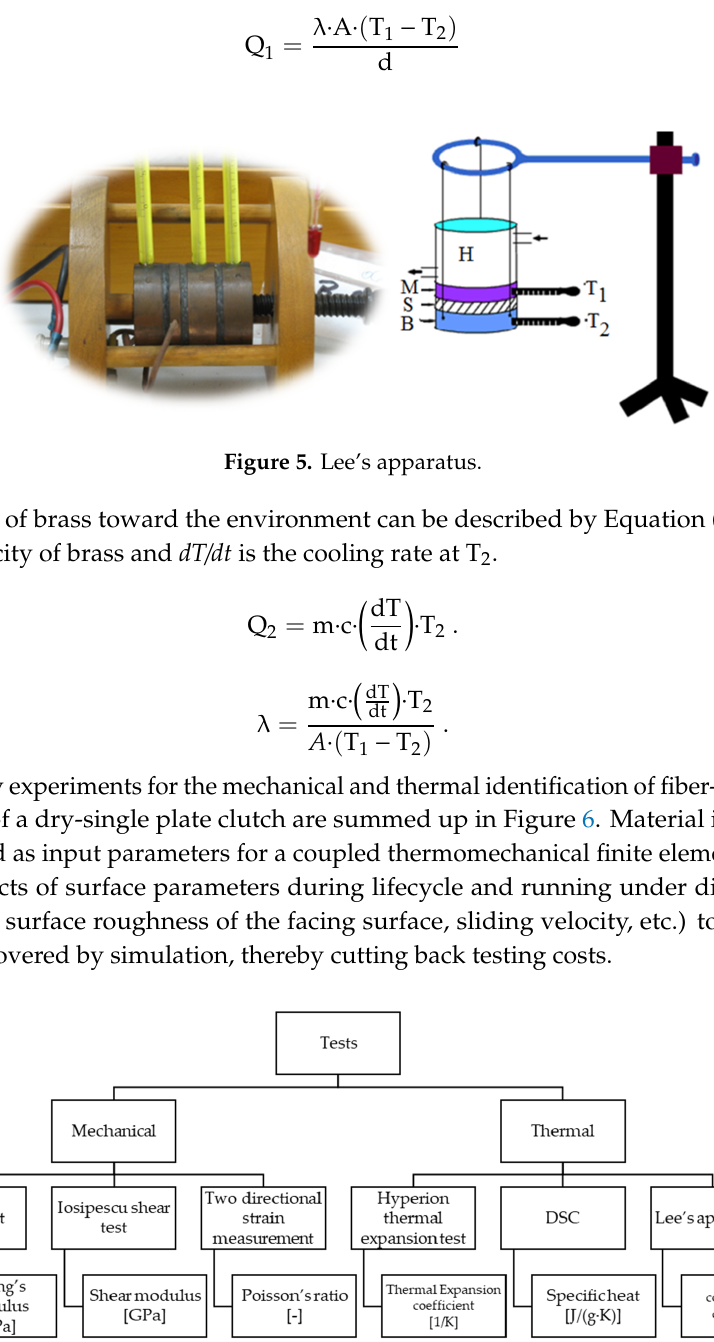
Figure 6. Material identification test summarization.